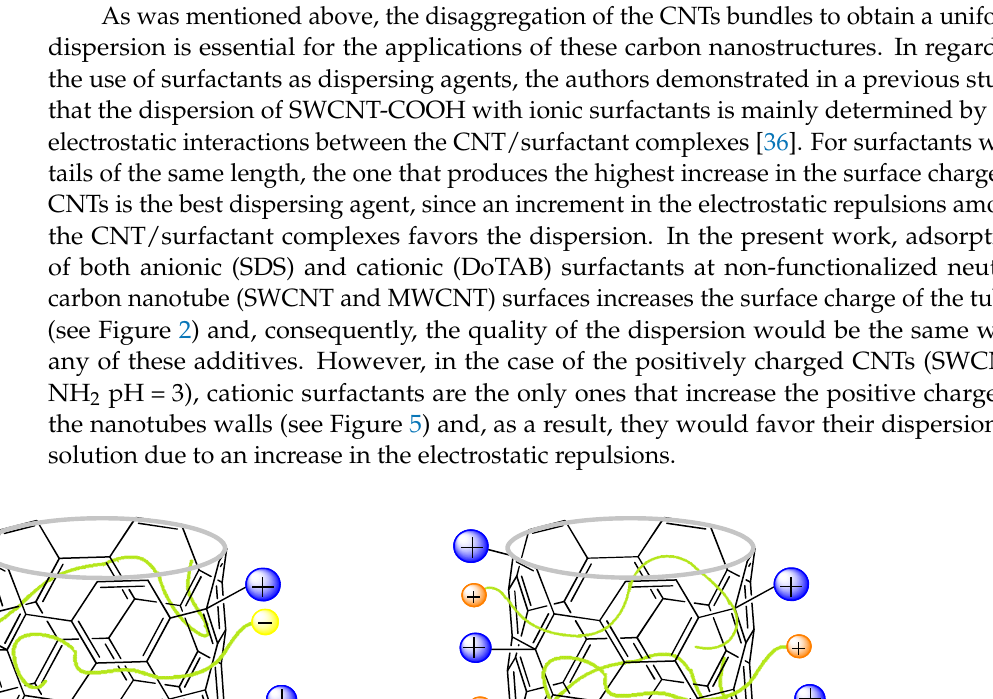
Table 1. Zeta-potential (ζ), size (d H ) and polydispersity index (PDI) values for different carbon nanotubes in the presence and absence of ionic surfactants.